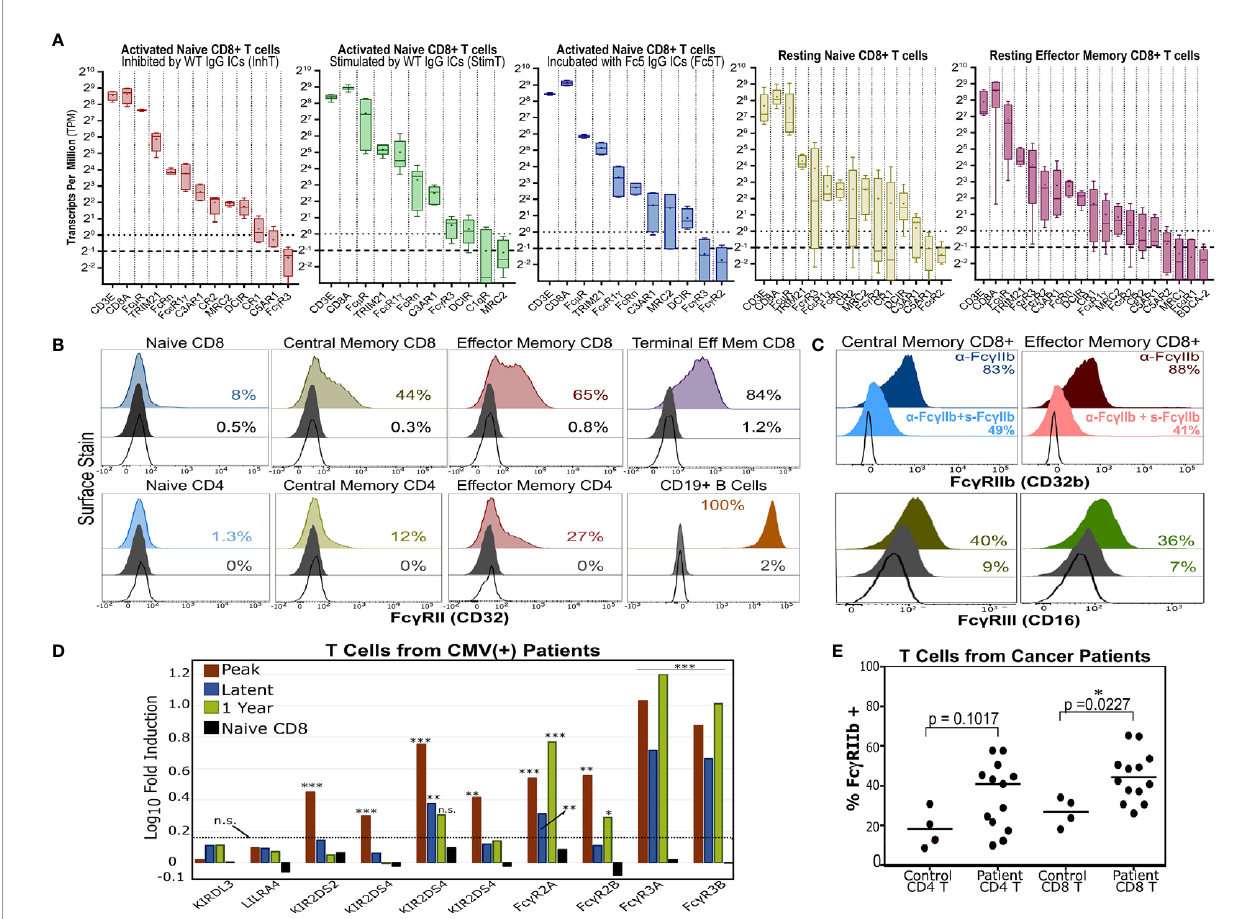
FIGURE 6 | T Cells Express Multiple Antibody Receptors. (A) mRNA of lectins and several antibody receptors in various T cell subsets. Results for “ resting ” subsets derive from RNA-Seq data published by Ranzani et al. (48) and pertain to sorted, non-stimulated cells (4-5 donors). The median (line), mean (dot), minimum/ maximum(whiskers), and interquartile range (box) are shown. The dotted and dashed lines represent the TPM=1 (expressed) and TPM=0.5 (very low expression) thresholds. TPMs for CD3E and CD8A are shown for reference. (B) Surface expression of Fc g RII (CD32) in various unstimulated T cell subsets. B cells serve as a positive control. (C) Fc g RIIb or Fc g RIII surface expression in memory CD8+ T cells. For Fc g RIIb, T cells were stained with an aglycosylated Fc g RIIb antibody with or without competing soluble, non fl uorescent Fc g RIIb. (B, C) Dark gray and un fi lled histograms represent isotype controls and non stained cells, respectively. Displayed percentages correspond to % positive events set relative to unstained cells. (D) Differential Fc g R gene expression in CD8+ T cells of HCMV-infected patients (vs. healthy donor CD8+ T cells). Results derive from microarray RNA data published by Van Stijn et al. (39). Various timepoints post-infection are shown (3 patients; 3 healthy donors). Non-Fc g R genes considered differentially expressed or unchanged by Van Stijn et al. are shown. Asterisks *, **, and *** represent p-values <0.05, p- values <0.01, and p-values < 0.001, respectively. n.s. stands for statistically not signi fi cant. The dashed line denotes the fold induction threshold below which no statistical signi fi cance was observed. (E) Fc g RIIb display in T cells isolated from PBMCs of healthy donors or cancer patients. The percent of Fc g RIIb(+) events is determined based on the FMO